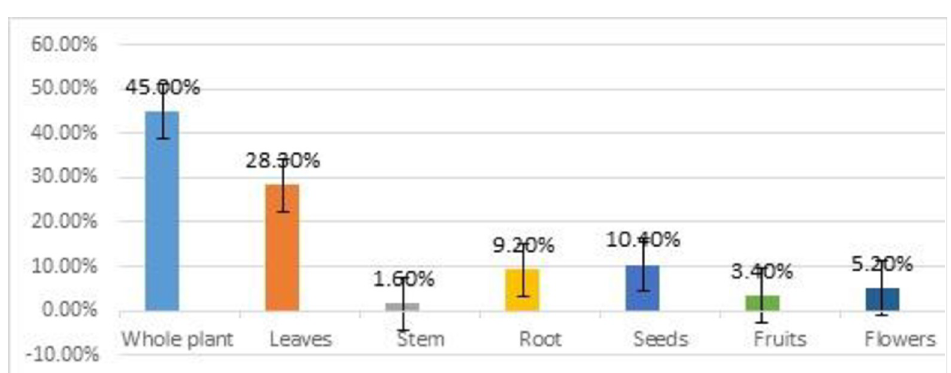
Table 6. Informant Consensus Factor (ICF) of herbal flora of SMR area of District Bhimber, AJK. S.